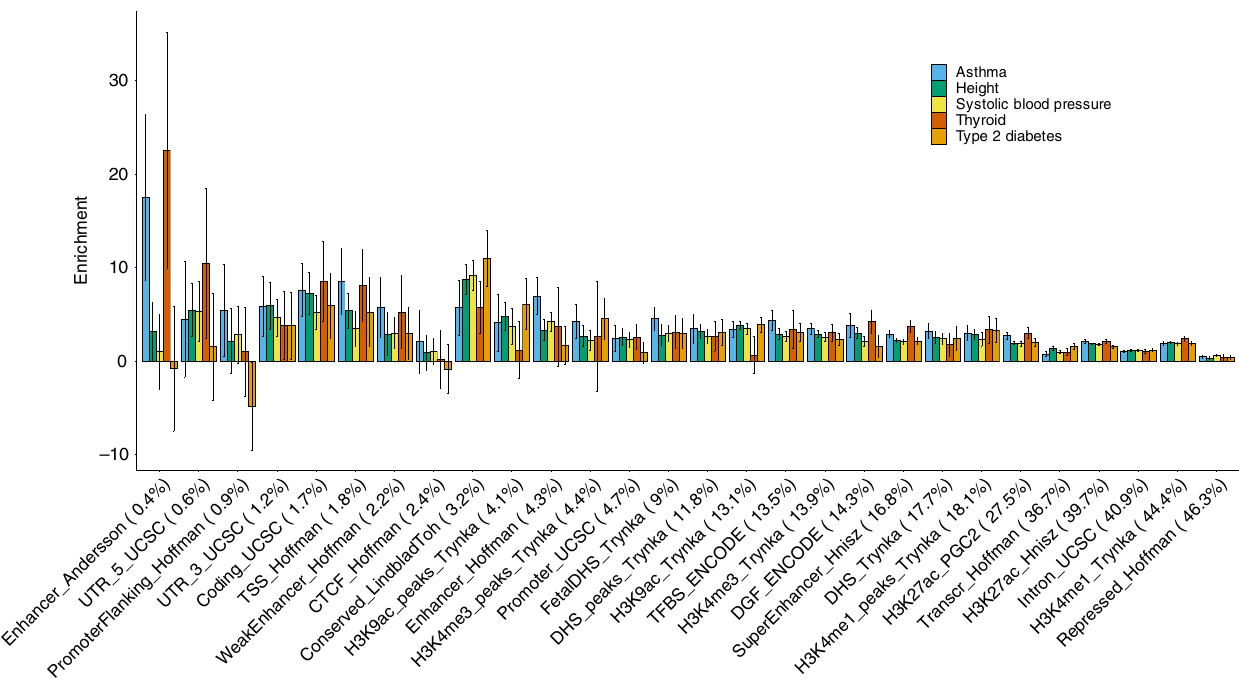
Fig. 6 Enrichment of heritability across 28 functional annotations. We applied RHE-mc to N = 291,273 unrelated white British individuals and M = 5,670,959 imputed SNPs (MAF > 0.1% and present in 1000 Genomes Project). SNPs were partitioned based on 28 functional annotations that were de fi ned in a previous study 7 . We grouped 22 traits in the UK Biobank into fi ve categories (autoimmune, diabetes, respiratory, anthropometric, cardiovascular). Here we plot enrichment of fi ve traits (one representative trait per category). Each bar represents the estimated enrichment. Black error bars mark ±2 standard errors centered on the estimated enrichment. Annotations are ordered by the proportions of SNPs in that annotation (given in parentheses). See Supplementary Fig. 8 for results on all 22